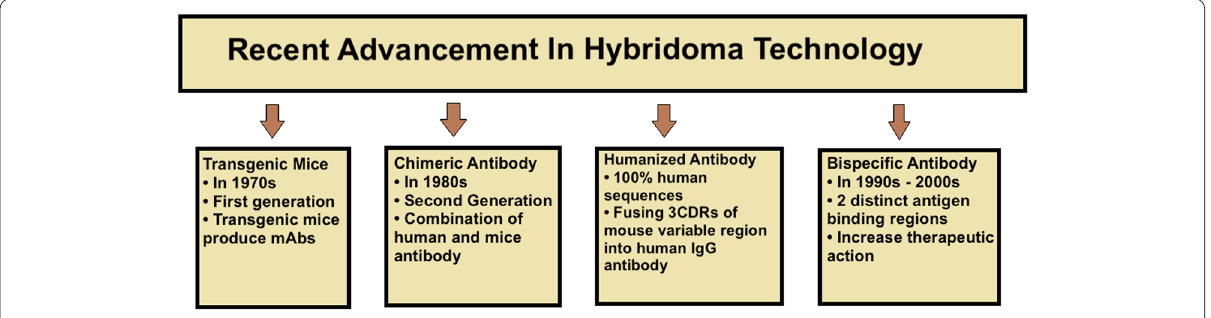
Fig. 6 Advancement in the field of hybridoma